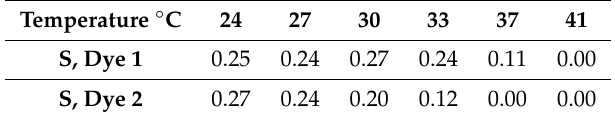
Table 1. Order parameter of 1 wt% Dye 1 and Dye 2 in 8CB in planar cells at di ff erent temperatures. Temperature ◦